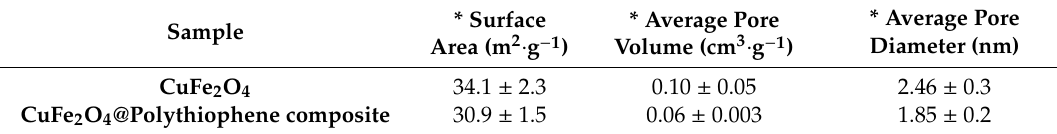
Table 1. Overall surface characteristic of proposed adsorbents that obtained by Brunauer–Emmett–Teller (BET) method.